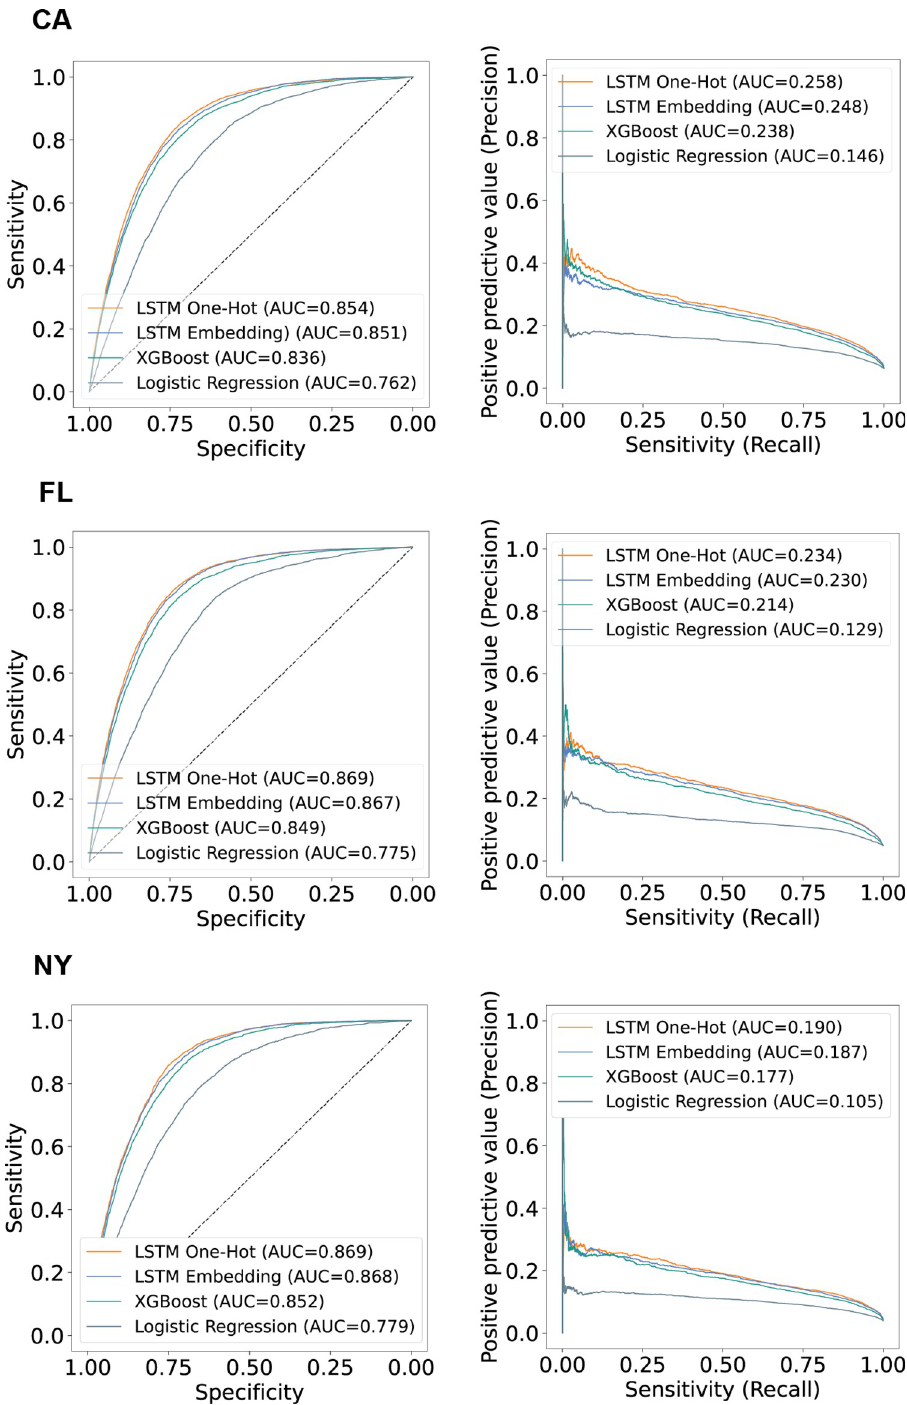
Fig 1. Receiver-operating characteristic (left) and precision-recall curves (right) for malnutrition prediction models, in three states. The long short-term memory (LSTM) models used longitudinal patient trajectories. The gradient-boosted tree model (XGBoost) used collapsed features from all visits. The logistic regression baseline model used only demographic data.